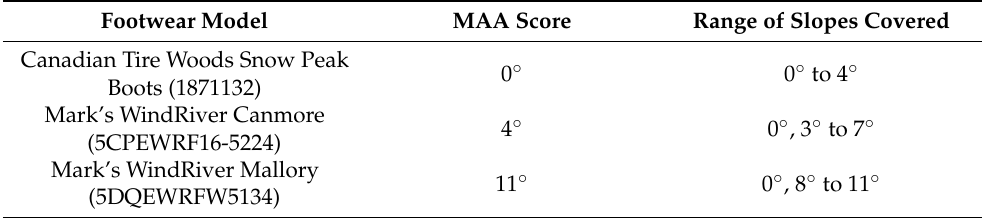
Table 2. Footwear models used for data collection.